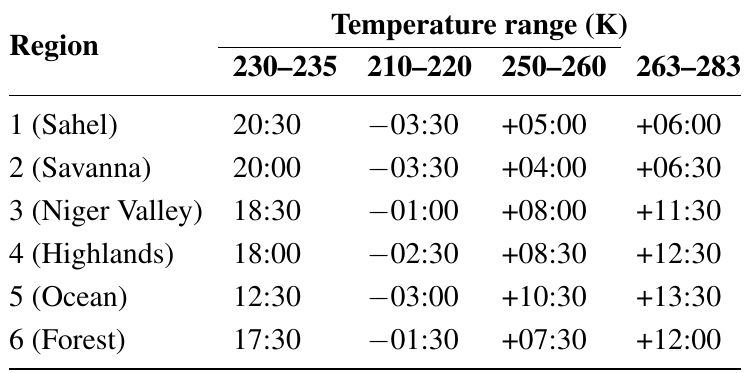
Table 1. Time of maximum cloud fraction as a function of the cloud-top temperature for different regions shown in Figure 1. The time of maximum of cloud fractions with brightness temperature in the range 230–235 K is given in local time and is used as reference time. Minus (plus) hours indicate peak of other categories before (after) the reference time